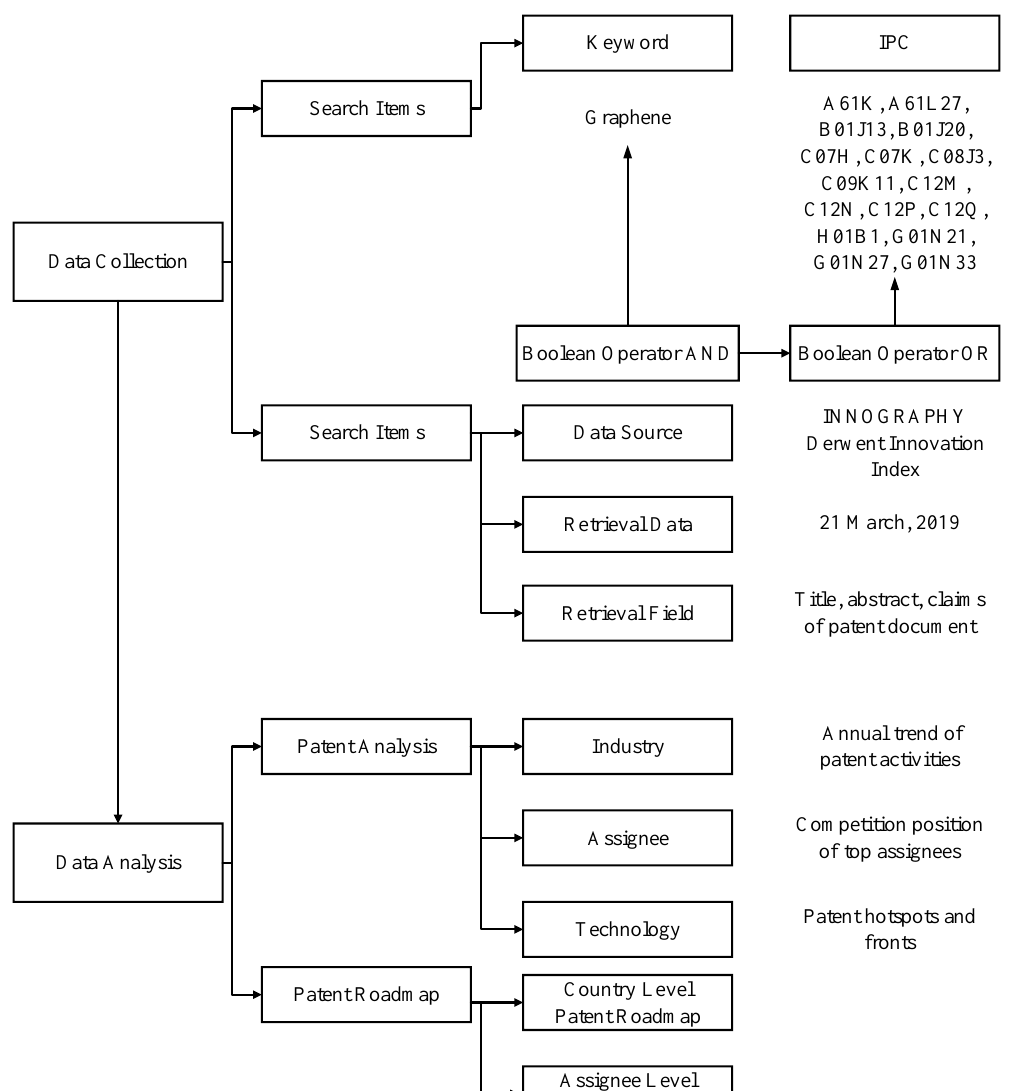
Figure 1. The outline of the research process. IPC: International Patent Classification.